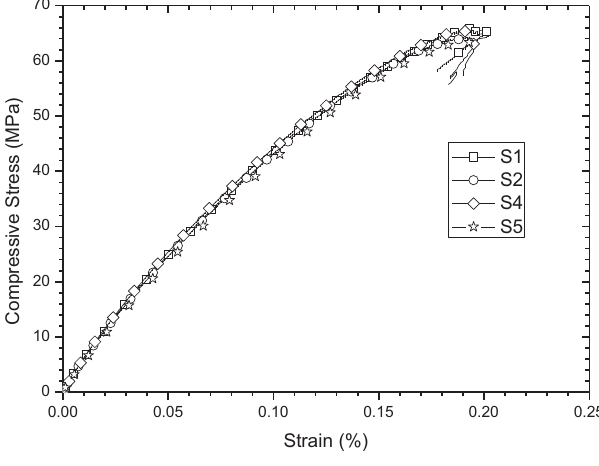
Figure 7 Stress vs. strain plots for the reference concrete